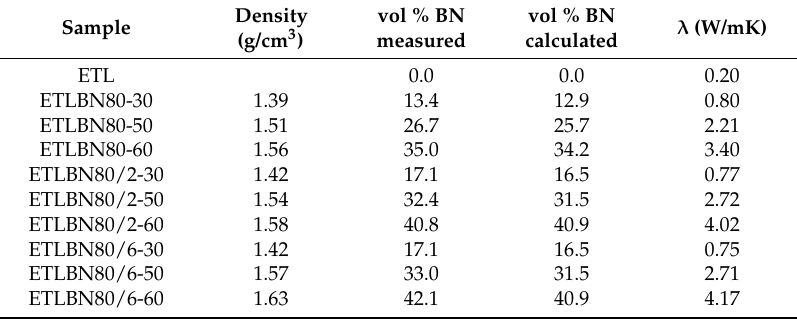
Table 4. Densities and thermal conductivities of samples studied, as a function of vol % BN.